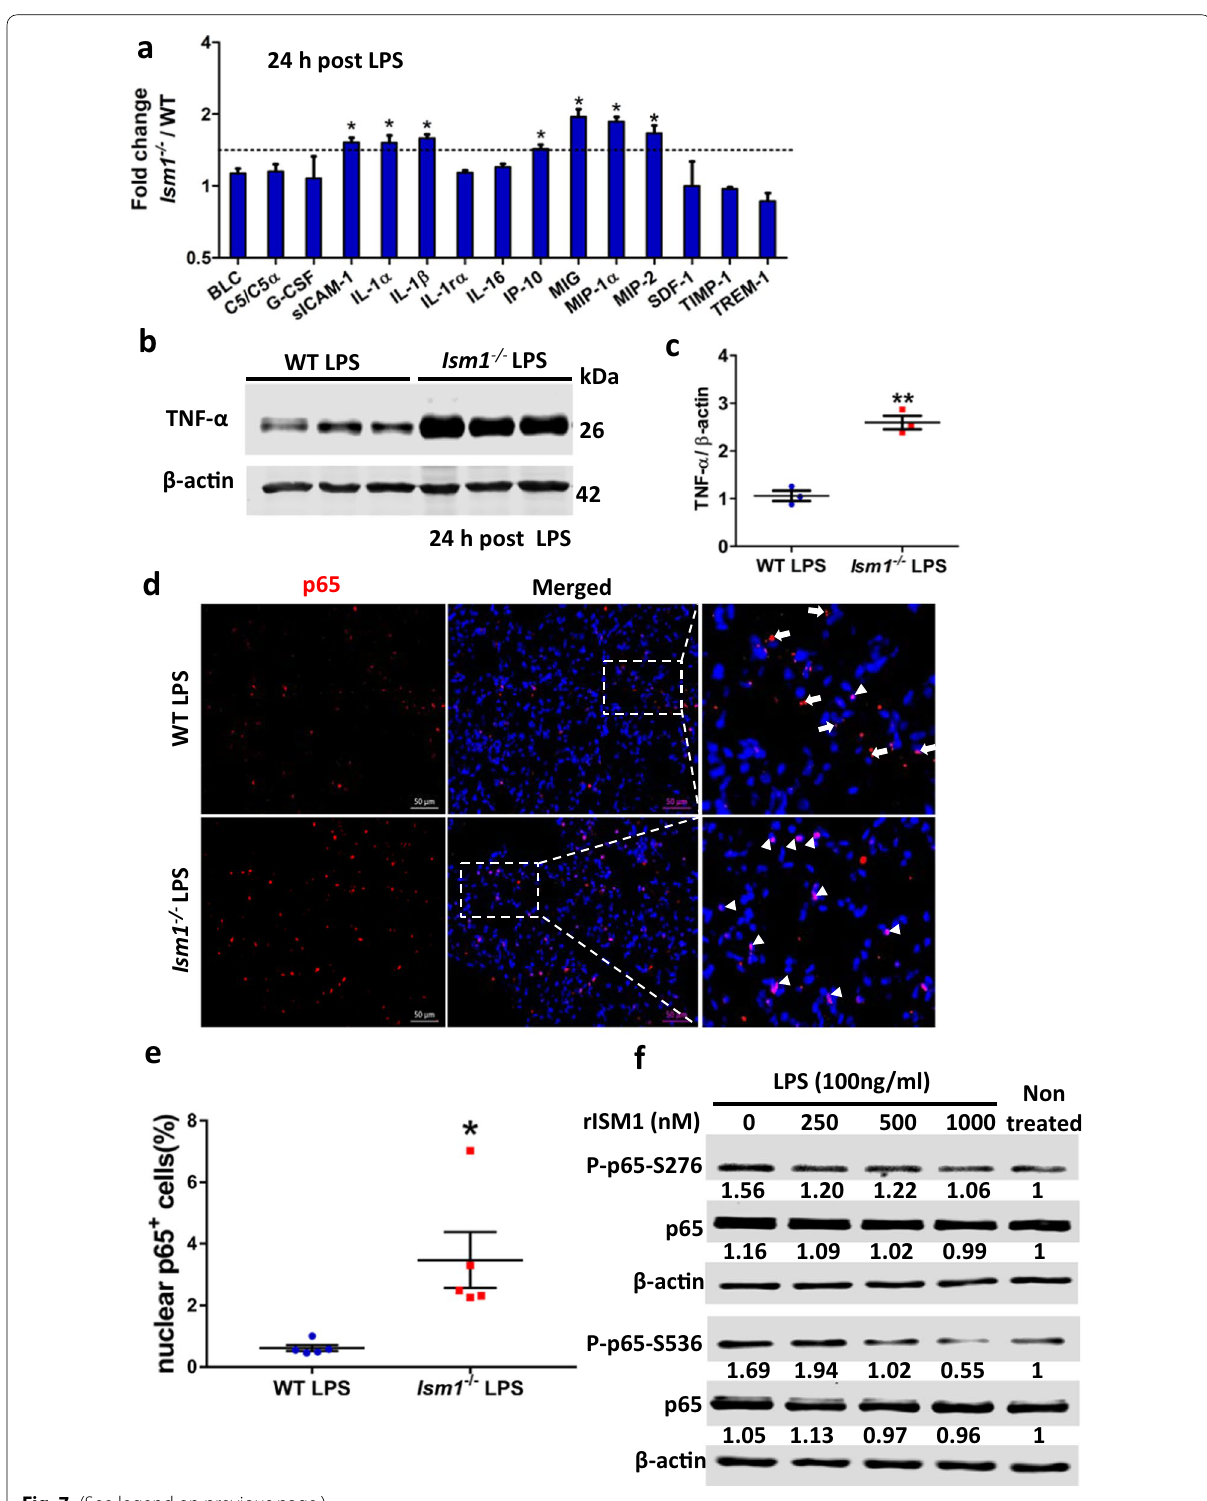
Fig. 7 (See legend on previous